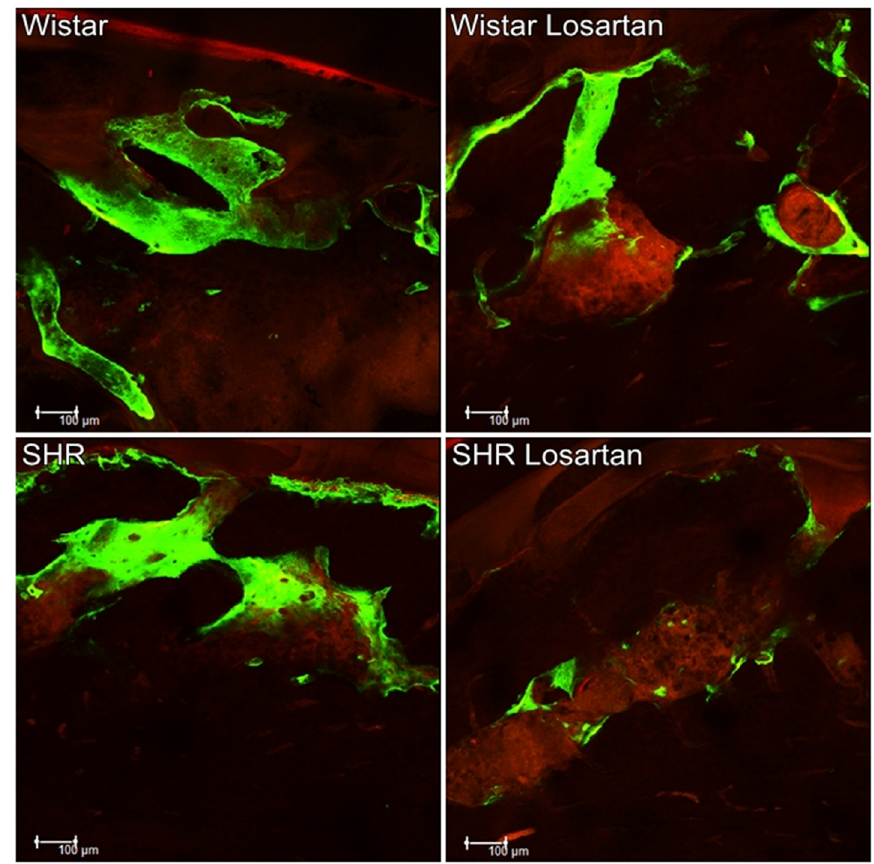
Figure 3- Alveolar bone dynamics. Representative image of bone dynamics by overlapping the fluorochromes of calcein and alizarin in the alveolar bone of the maxilla in each group for Wistar, Wistar Losartan, SHR, and SHR Losartan using the Image J (Processing Software and Image Analysis, Ontario,